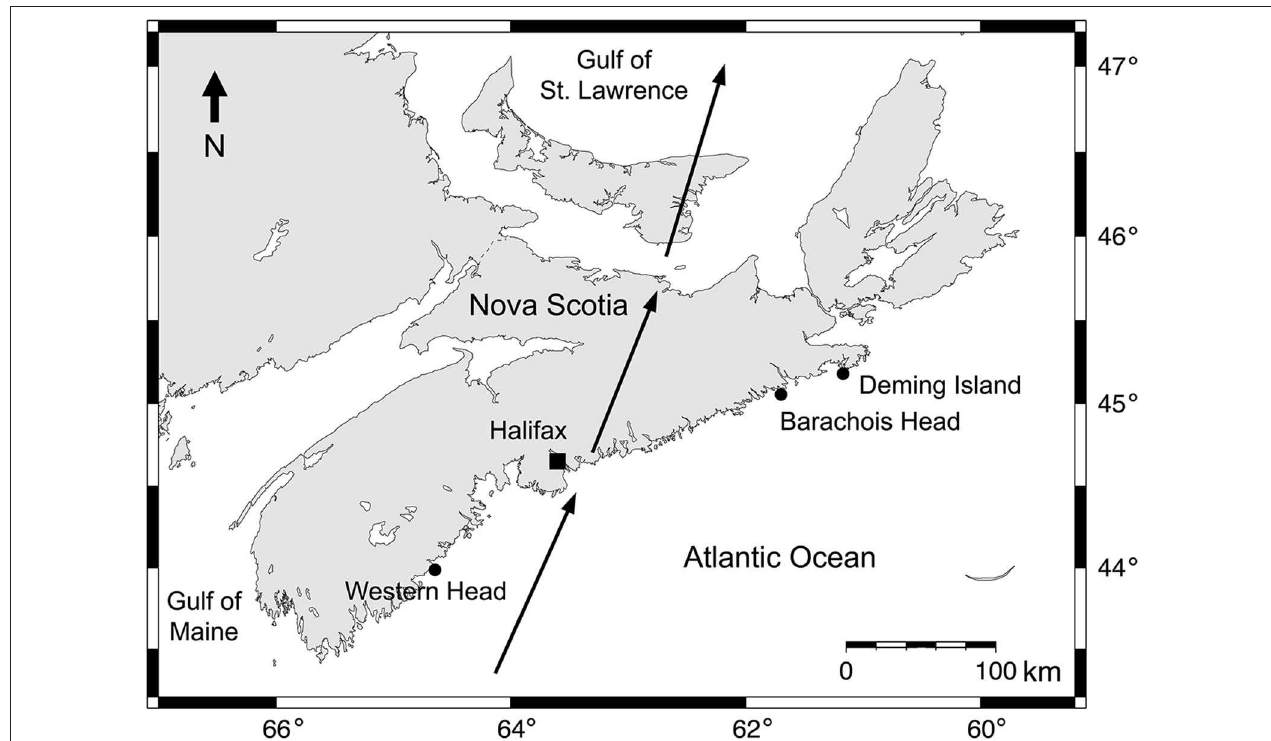
FIGURE 1 | Map of Nova Scotia, showing the path of cyclone Dorian’s center (arrows) and the position of Western Head and the two previously studied locations (Deming Island and Barachois Head) east of Dorian’s